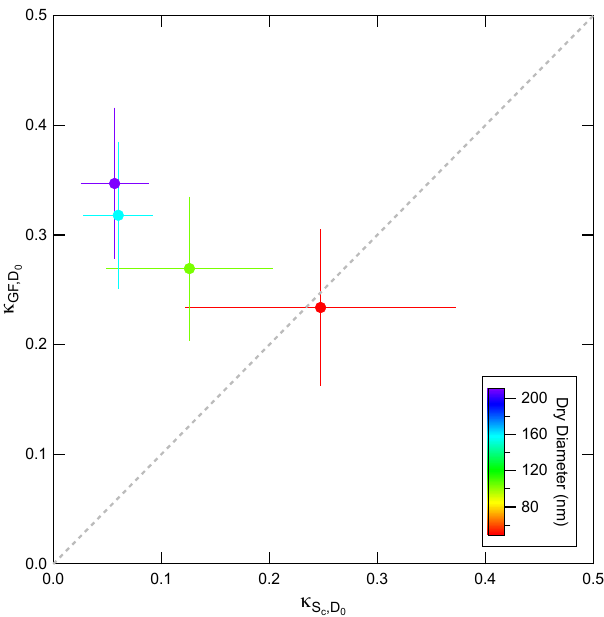
Fig. 8. κ GF , D0 as measured from the HTDMA vs. κ Sc , D0 as mea- sured by the CCNc, as a function of dry diameter. Note, the CCNc diameters are not on the same diameter base and have been binned as described in the main text.